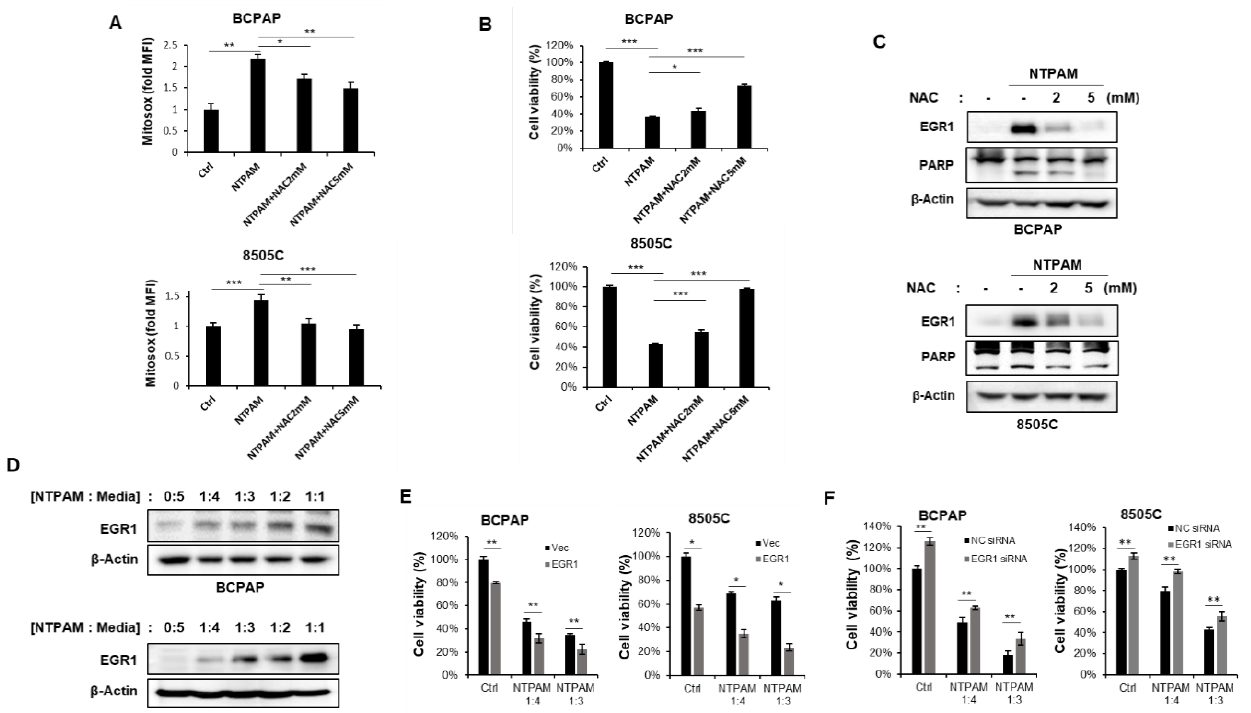
Figure 5. NTPAM induces cell death through the regulation of ROS-induced EGR1 in THCA cells. BCPAP and 8505C cells were treated with 2 h dose-NTPAM for 6 h or cotreated with NTPAM and NAC. ( A ) Mitochondrial ROS levels were measured by Mitosox-based flow cytometry. Results were analyzed using non-parametric one-way ANOVA followed by Dunnett’s post-hoc test. ( B ) Cell viability was evaluated using the WST1 assay. Results were analyzed using non-parametric one-way ANOVA followed by Dunnett’s post-hoc test. ( C ) Cell lysates were assessed by western blot analysis using antibodies against EGR1, PARP, and β-actin. ( D ) BCPAP and 8505C cells were treated with NTPAM for 24 h in a dose-dependent manner up to 1:4 dilution and cell lysates were assessed by western blot analysis using an antibody against EGR1. ( E ) BCPAP and 8505C cells were transfected with or without EGR1 vector for 48 h, and then cells were treated with NTPAM for 24 h at the indicated concentrations. Cell viability was analyzed using the WST1 assay. Results were analyzed using Mann-Whitney U test. ( F ) BCPAP and 8505C cells were transfected with or without EGR1-specific siRNA for 48 h, and then cells were treated with NTPAM for 24 h at the indicated concentrations. Cell viability was analyzed using the WST1 assay. Results were analyzed using Mann-Whitney U test. Each figure is representative of three independent experiments. Data were expressed as mean ± standard deviation of the mean (±SD). Differences were considered relevant at p < 0.05 (* p < 0.05, ** p < 0.01, *** p < 0.001).